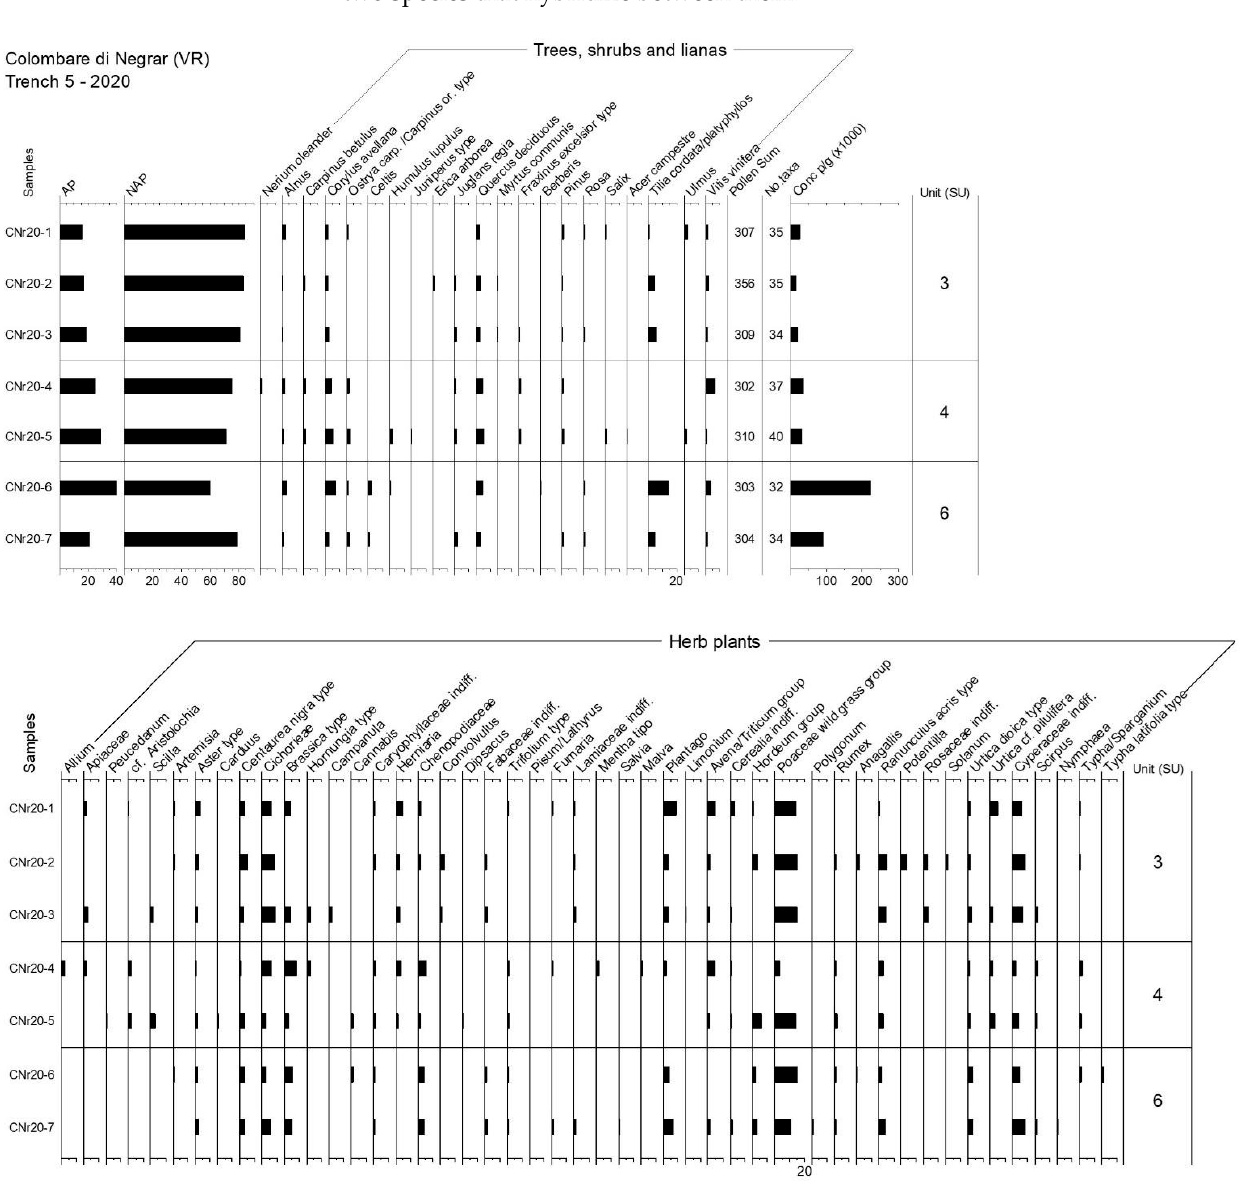
Figure 4. Colombare di Negrar: Percentage pollen diagram of Trench 5—2020; histograms show data from the 7 samples taken as drawn in Figure 2.